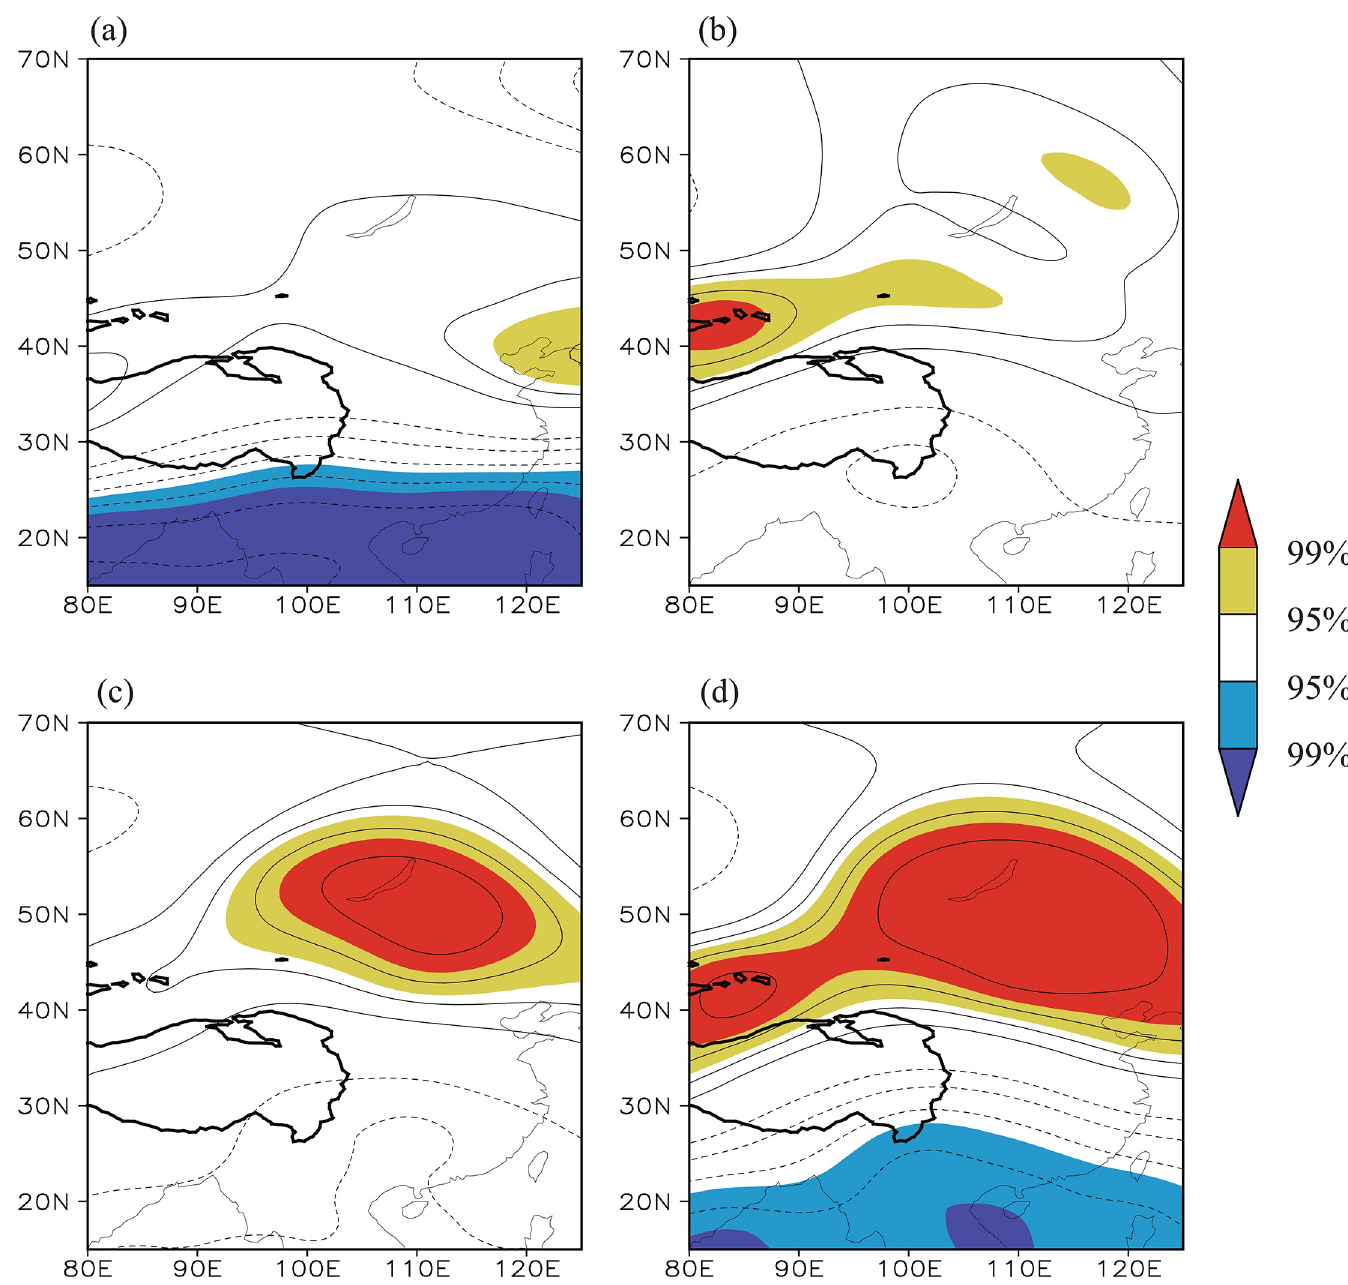
Fig 10. Distribution of the correlation coefficients between the summer (a) negative tropical eastern Pacific Ocean SST index/(b) negative subtropical north Atlantic Ocean SST index/(c) positive northwest Pacific Ocean SST index/(d) synergistic SST index and the simultaneous 200 hPa geopotential height field during the time period 1982–2014. The yellow (red) shading denotes a positive correlation significant at the 95% (99%) confidence level and the blue (purple) shading denotes a negative correlation significant at the 95% (99%) confidence level. https://doi.org/10.1371/journal.pone.0239465.g010 The vertical circulation and geopotential height anomalies regressed upon the I a cross section along 155˚E (Fig 12A) show anomalous upward motions over the northwest Pacific Ocean and correspondingly a significant positive anomaly appears in the upper tropo- sphere around 40˚ N, to the east of Japan, which can be regarded as a result of a warmer SST